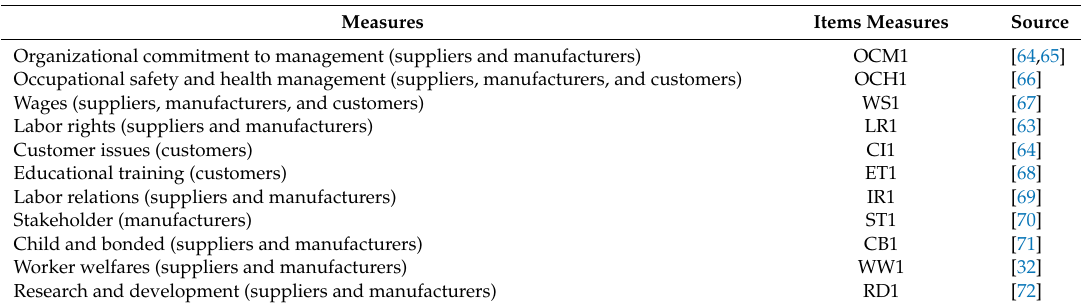
Table 2. Dimensions of social sustainability in the supply chain according to literature (scale items and measures for social sustainability)